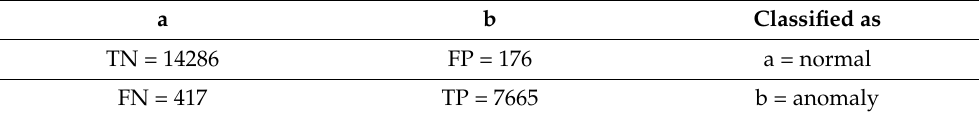
Table 9. Confusion matrix for the hybrid K-mean and SMO method.